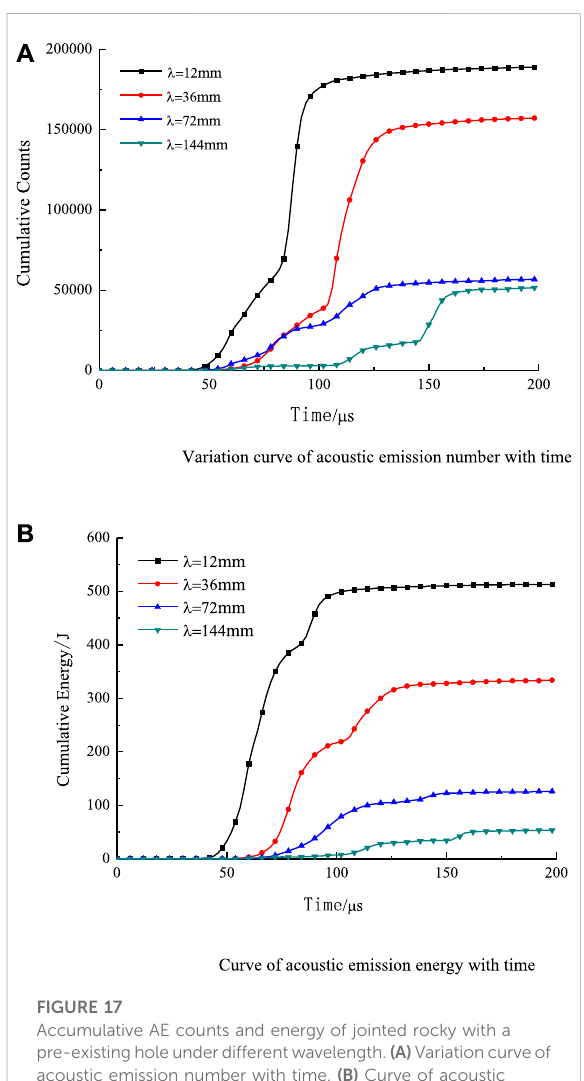
FIGURE 17 Accumulative AE counts and energy of jointed rocky with a pre-existingholeunderdifferentwavelength. (A) Variationcurveof acoustic emission number with time. (B) Curve of acoustic emission energy with